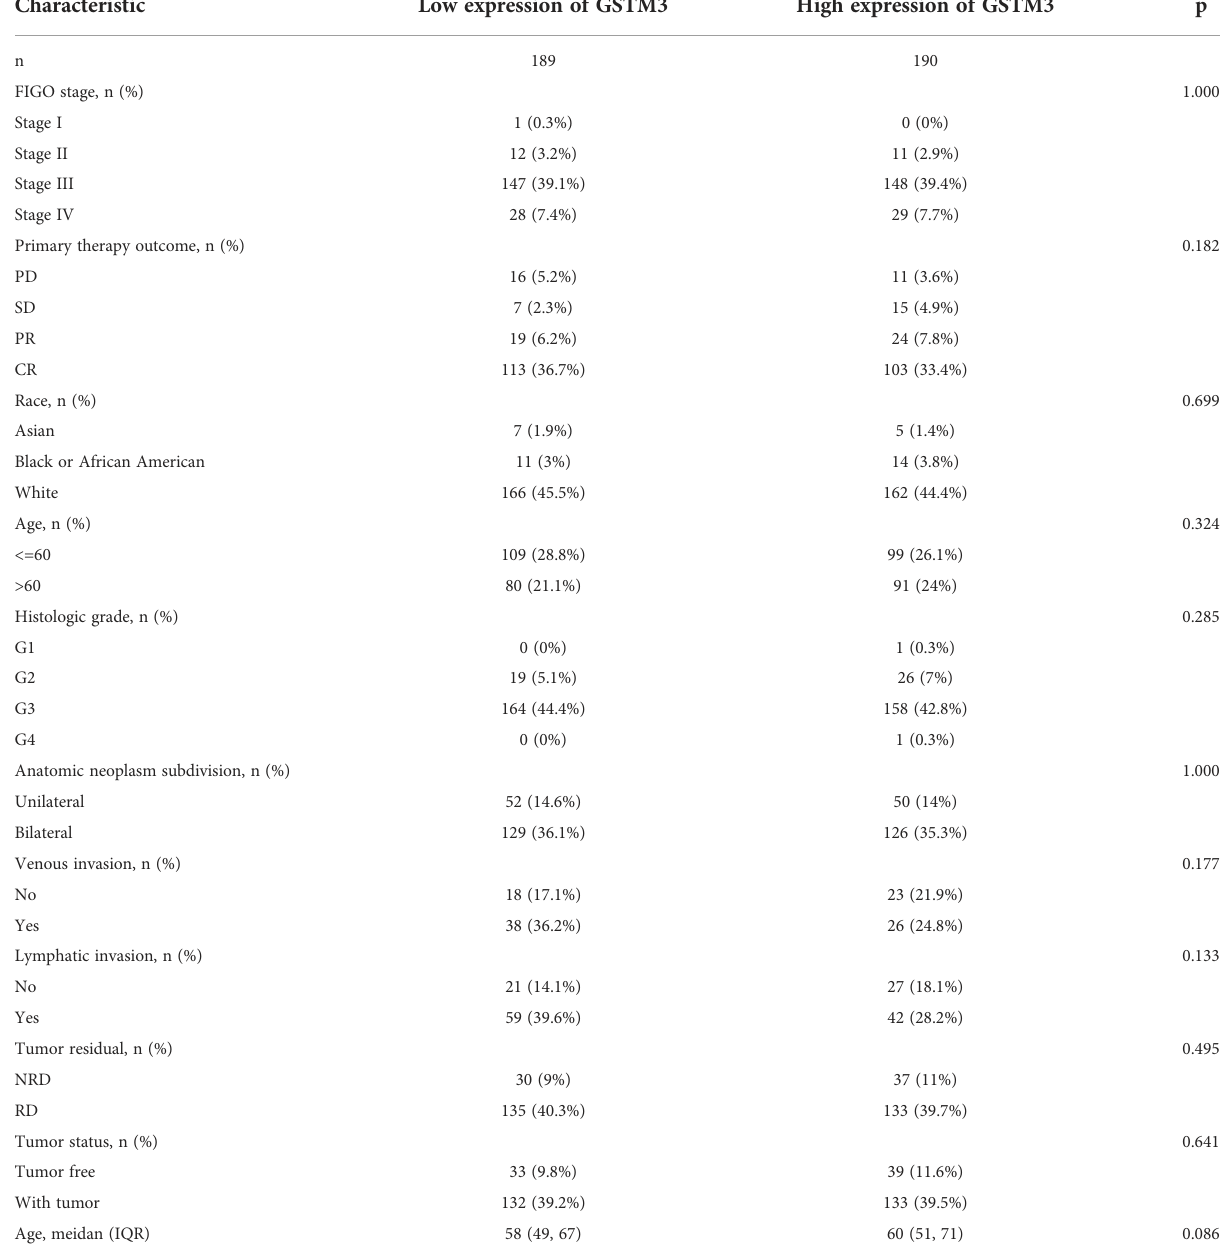
TABLE 3 The correlation between pathological parameters and GSTM3